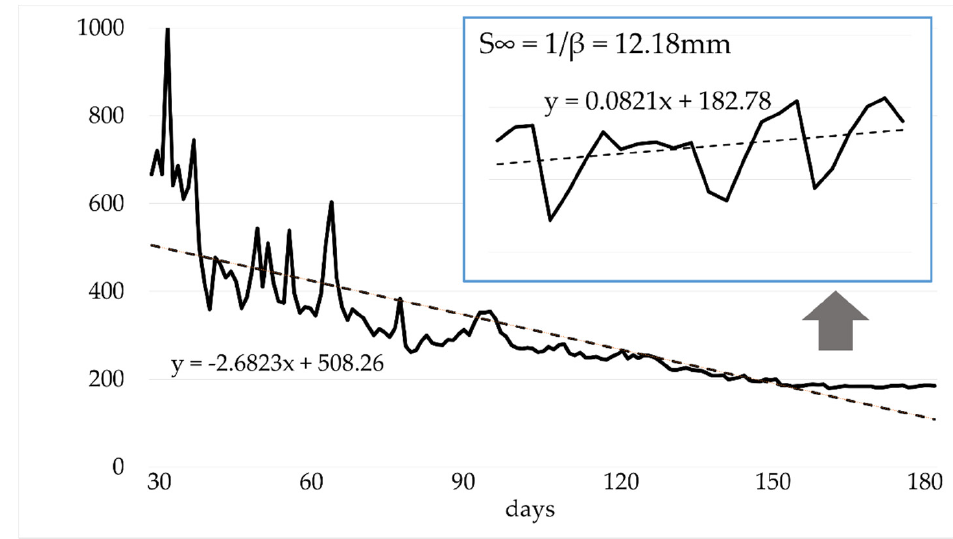
Figure 8. Long-term settlement predicted by the hyperbolic method.